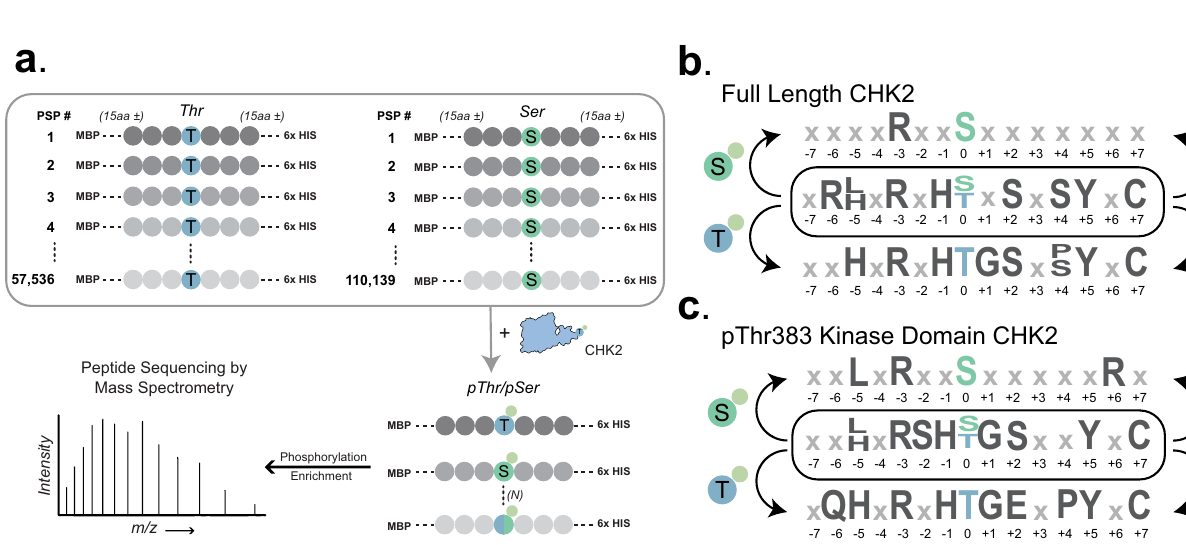
LC-MS/MS for b full-length CHK2 and c pThr383 CHK2 KD subclassi fi ed by Ser (top), Thr (bottom), and Ser/Thr (middle) phosphosite library IDs. Only signi fi